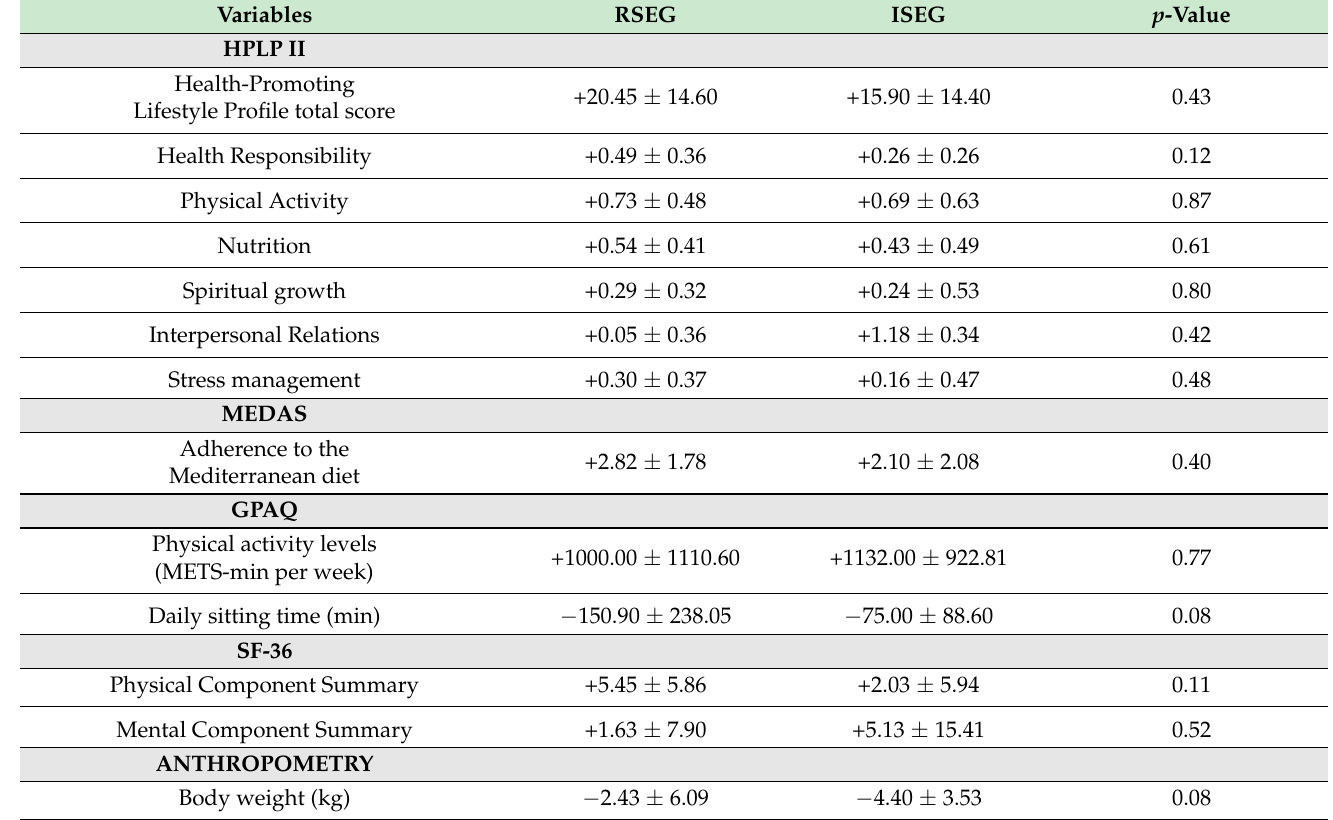
Table 2. Between-Group Comparisons in Total Change in Lifestyle and Health-Related Quality